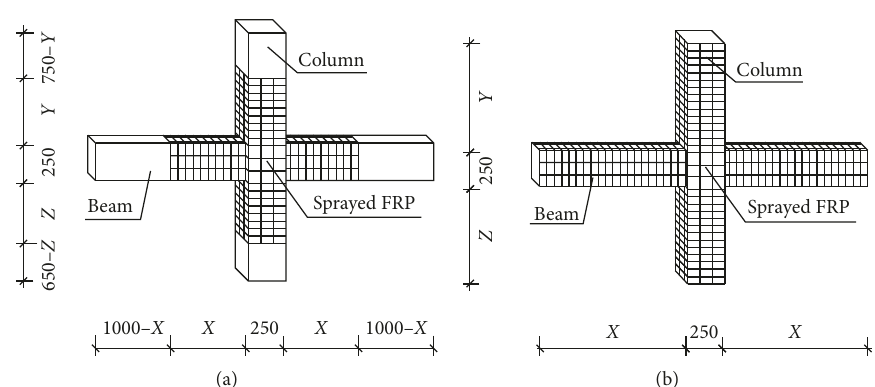
Figure 2: Strengthening diagram of the test specimen. (a) Partially strengthening (RJ1, RJ2, and RJ3) and (b) full-length strengthening